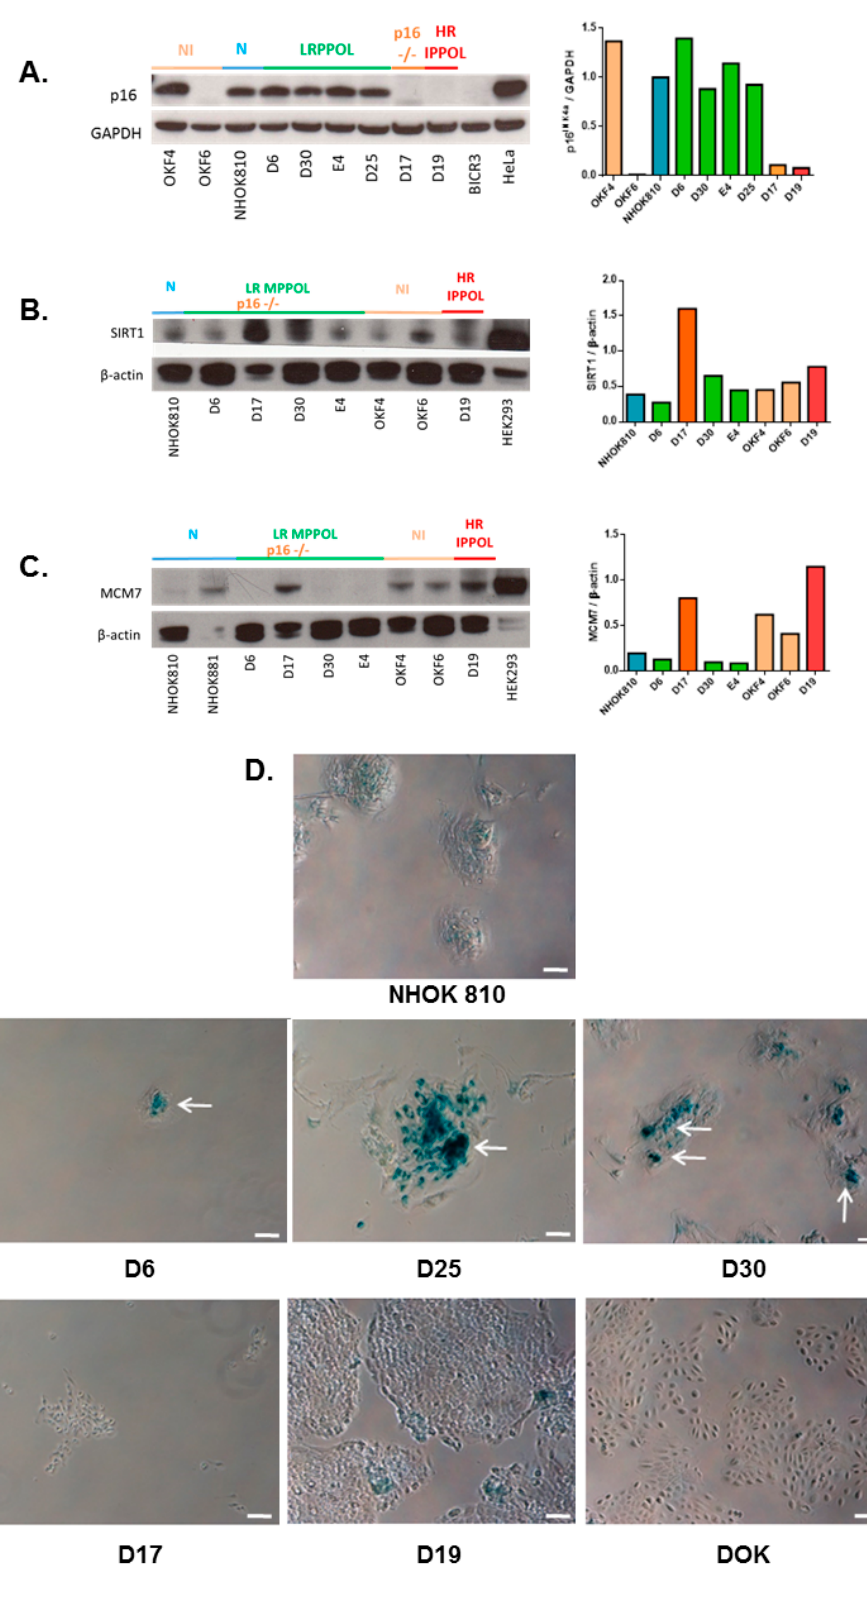
Figure 2. Characterisation of the senescence markers in the cell lines used in this study. Western blots of ( A ) p16 INK4A in normal keratinocyte NHOK810 (N—blue colour bar above Western blot images and in graph), normal oral keratinocytes immortalised by telomerase (NI—beige colour) retaining (OKF4) or lacking (OKF6) p16 INK4A expression, low-risk mortal potentially premalignant oral lesion D6, D25, D30, and E4 (LR MPPOL—green colour), LR MPPOL extended lifespan